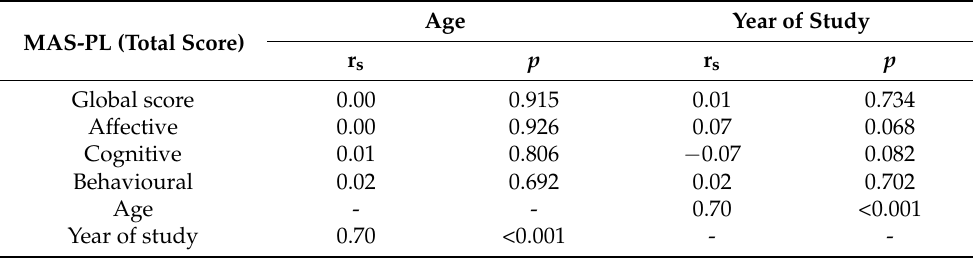
Table 6. Assumption of Spearman’s correlation analysis of MAS-PL scores (total score, affective, cognitive and behavioural subscales) with age and year of study (N =